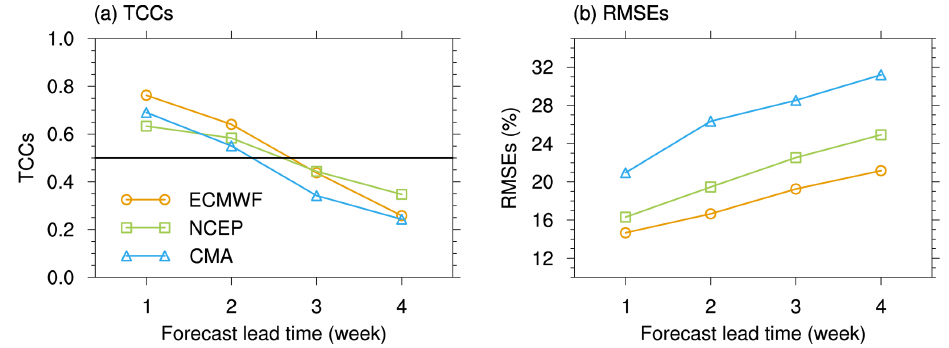
Figure 2. Prediction skill of the Tibetan Plateau snow cover (TPSC) index in the S2S models during wintertime. (a) The temporal correlation coefficients (TCCs; y axis) between the observed TPSC index and the predicted TPSC index in the ECMWF (orange line), NCEP (green line) and CMA (blue line) models during winter. The x axis represents the forecast lead time (unit: week). A good prediction skill has a TCC that is greater than 0.5 (marked by black line). Panel (b) is similar to panel (a) but is for the root-mean-square errors (RMSEs; y axis, unit: